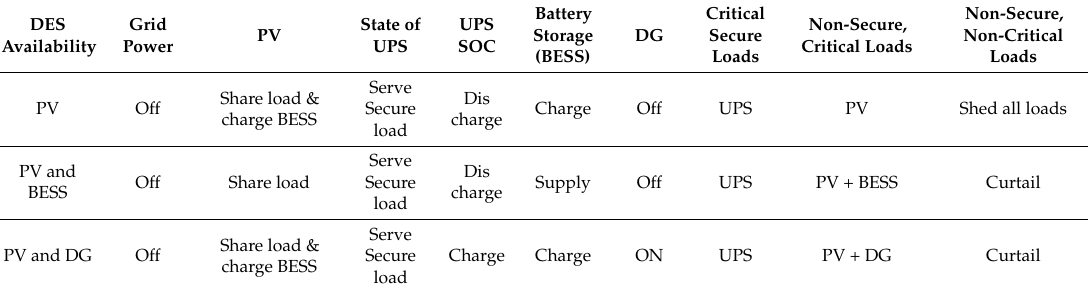
Table 4. Power sharing between DES, Grid and Loads during Off Grid mode of